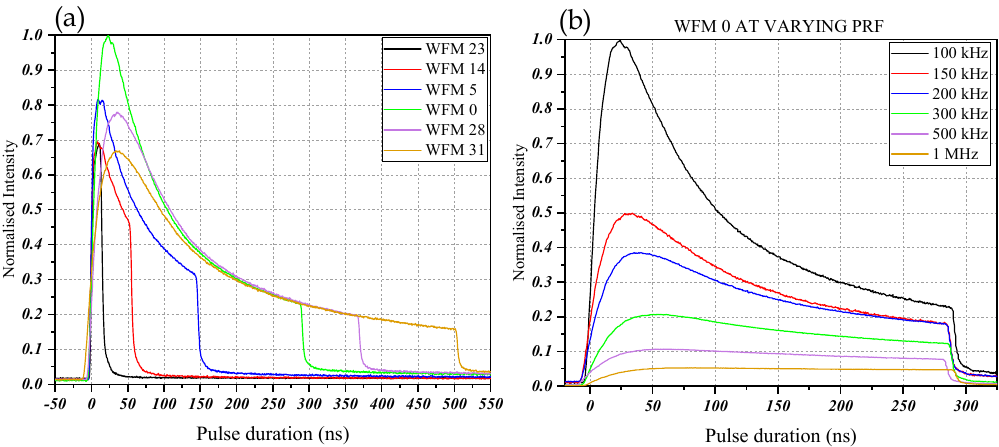
Figure 1. ( a ) Measured temporal profiles of some selected waveforms shortlisted for the experimental work. WFM 23 (17 ns), WFM 14 (60 ns), WFM 5 (150 ns), WFM 0 (280 ns), WFM 28 (380 ns), and WFM 31 (500 ns). ( b ) Temporal profile as a function of pulse repetition frequency (PRF) for WFM 0.